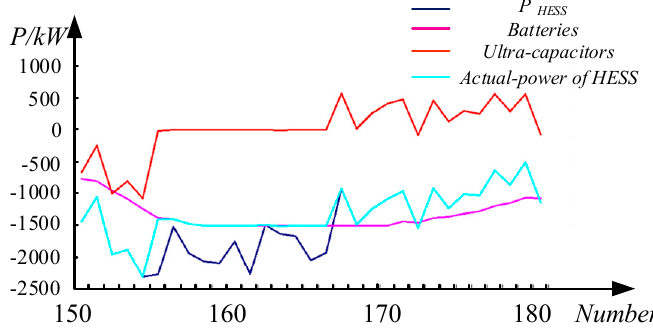
for sample points 150–180. HESS